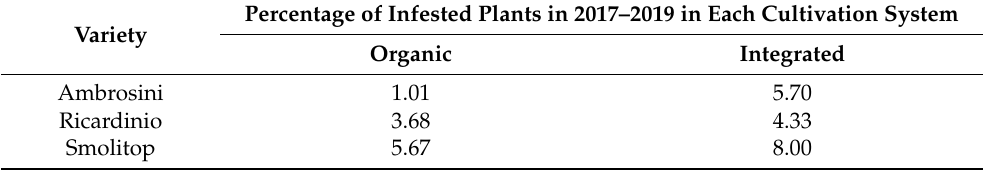
Table 6. The infestation of maize varieties with corn smut depending on the cultivation system. Percentage of Infested Plants in 2017–2019 in Each Cultivation System Variety